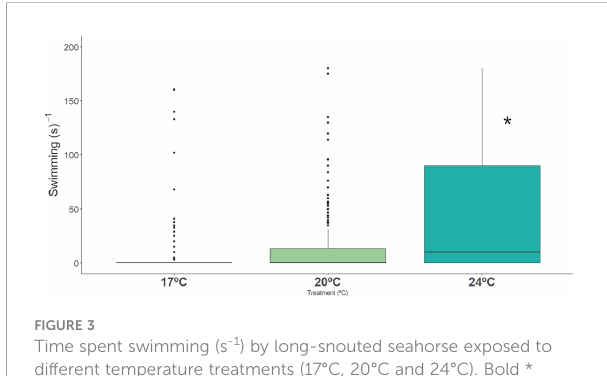
FIGURE 3 Time spent swimming (s -1 ) by long-snouted seahorse exposed to different temperature treatments (17°C, 20°C and 24°C). Bold * represent signi fi cant differences from control